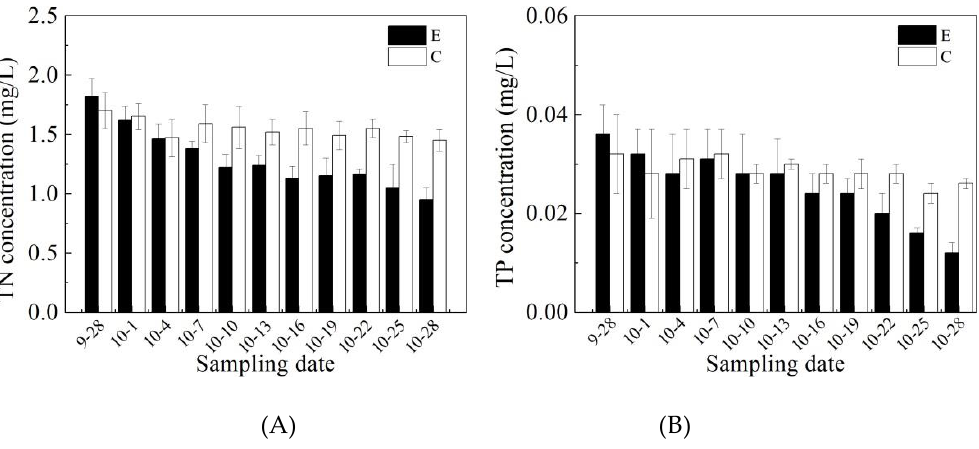
Figure 2. Changes in total nitrogen (TN) ( A ) and total phosphorus (TP) ( B ) concentrations (mean values) in the enhanced area and in the control area during the period of operation of the water-lifting aeration system. In the legends, C stands for “control area” and E for “enhanced area”. As shown in Figure 3, TOC concentrations in the enhanced area and control area present the same trend as the TN concentrations. The TOC of the enhanced area decreased from 3.5 to 2.7 mg/L,